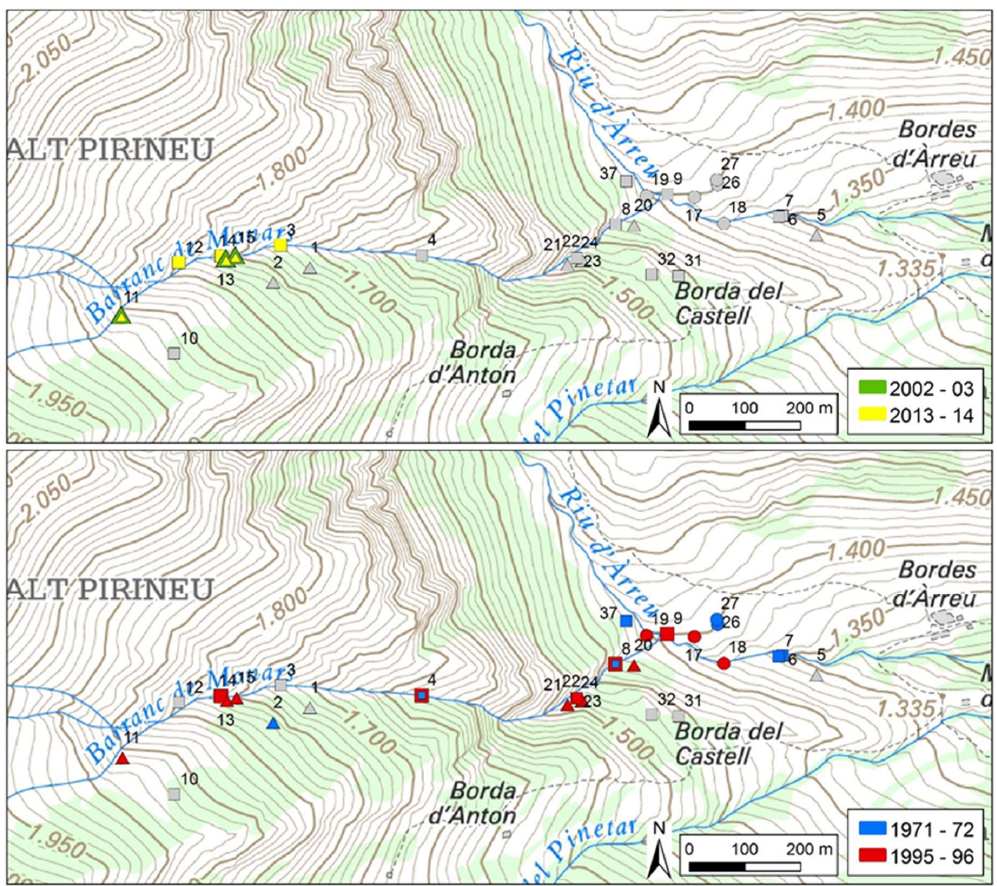
Figure 11. Extent of different avalanches identified by dendrogeomorphological analysis. Above: High-frequency events in 2002–03 and 2013–14 (every 5–6 years) which stopped above Monars gorge at 1650 m a.s.l.; below: Lower-frequency events in 1995–96 and 1971–72 which had larger but slightly different runouts. (All sampled trees are numbered and symbolized by shapes depending on tree species: Birches, in squares; pine trees, in triangles; ash trees, in circles. In gray, sampled trees showing no GD in that year. Shapes in two colors symbolize trees with GD from two different events.) Geosciences 2020 , 10 , x FOR PEER REVIEW 14 of 26 Table 1. Estimated return period of the registered avalanches.